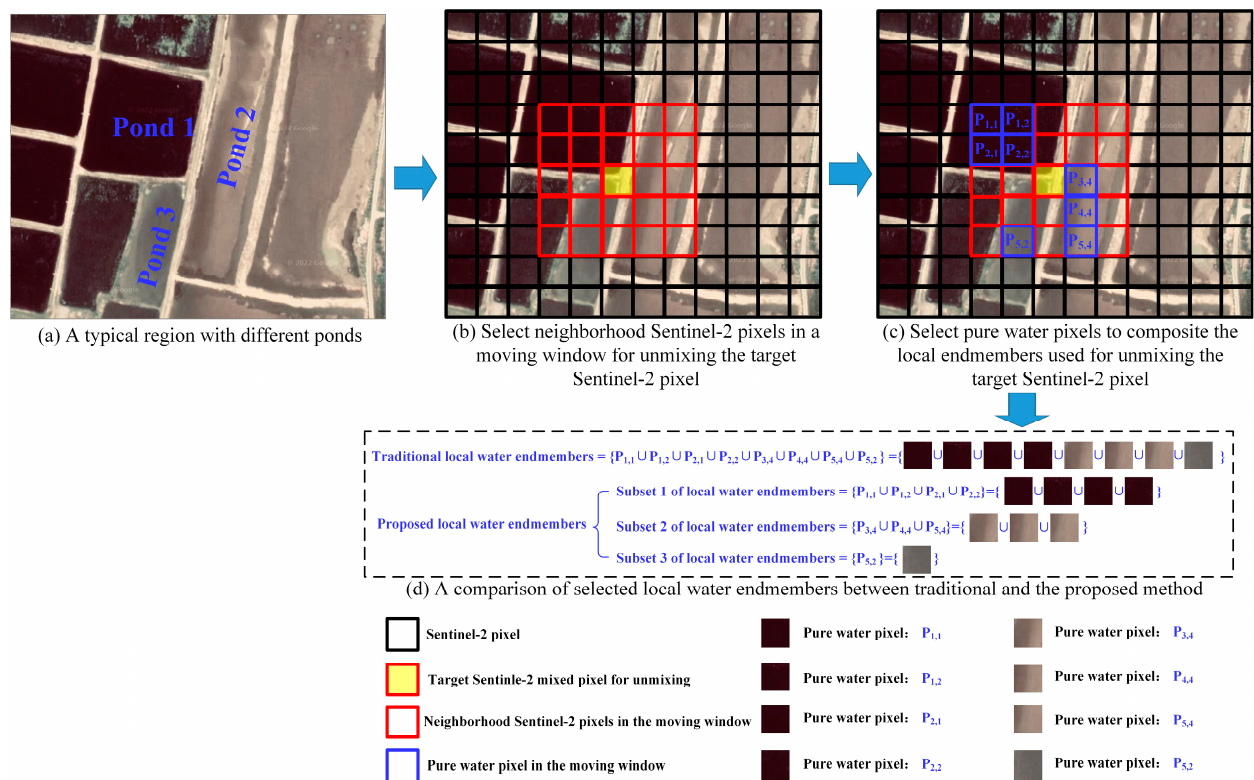
Figure 3. Sketch map illustrating the pure water pixels from di ff erent clusters for local water endmember extraction. ( a ) A typical region with di ff erent ponds. ( b ) Neighborhood Sentinel-2 pixels selected in a moving window. ( c ) Pure water pixels to composite the local endmembers. ( d ) Selected local water endmembers. The 5 × 5–sized local window contains eight pure water pixels, i.e., P 1,1 , P 1,2 , P 2,1 , P 2,2 , P 3,4 , P 4,4 , P 5,4 , and P 5,2 , highlighted with blue rectangles in ( c ). Pixels P 1,1 , P 1,2 , P 2,1